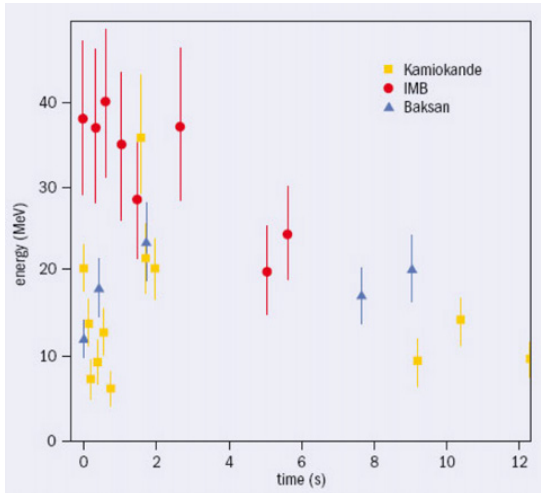
Figure 3. SN1987A neutrino events observed by Kamiokande, IMB and Baksan showed that the neutrino burst lasted about 13 s [2].